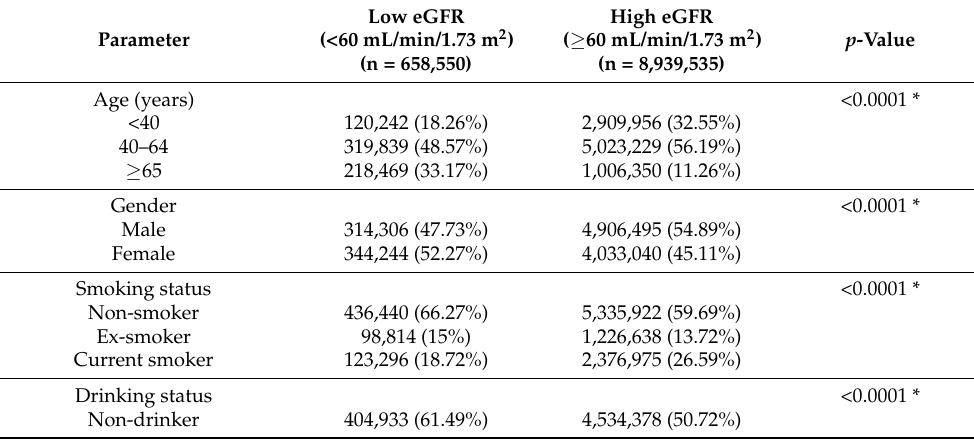
Table 1. Analysis of factors potentially associated with estimated glomerular filtration rate (n =